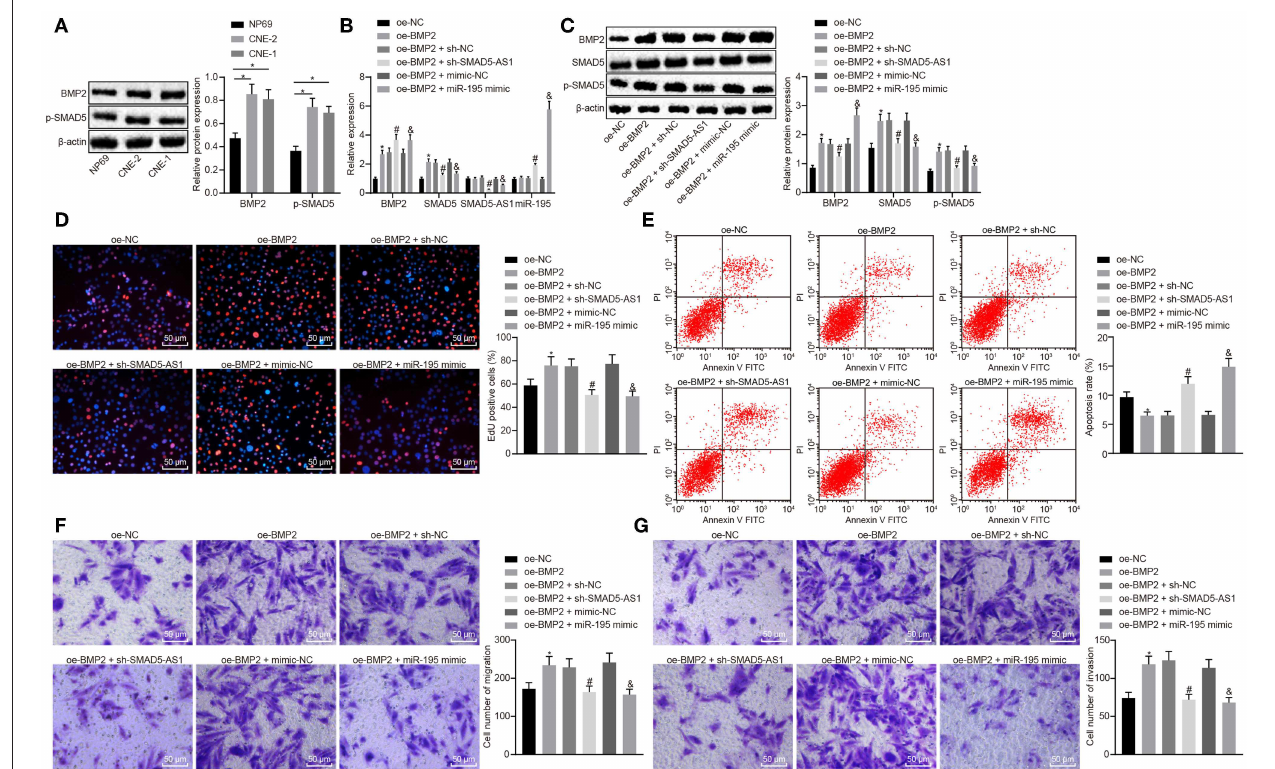
FIGURE 6 | Silencing of SMAD5-AS1 or miR-195 overexpression impeded CNE-2 cell proliferating, migrating and invading abilities via blocking the BMP2/SMAD5 pathway. (A) The protein expression of BMP2 and phosphorylated SMAD5 in CNE-2 cells measured using western blot analysis. *** p < 0.001 vs. NP69; ** p < 0.01 vs. NP69. (B) The expression of BMP2, miR-195, SMAD5, and SMAD5-AS1 in CNE-2 cells determined using RT-qPCR. (C) The protein expression of BMP2, SMAD5 and phosphorylated SMAD5 in CNE-2 cells measured using western blot analysis. (D) CNE-2 cell proliferation assessed by EdU assay. (E) CNE-2 cell apoptosis rate measured by flow cytometry. (F) CNE-2 cell migration evaluated by Transwell assay (200 × , scale bar = 50 um). (G) CNE-2 cell invasion evaluated by Transwell assay (200 × , scale bar = 50 um). In (B–G) , * vs. the oe-NC group, # p < 0.05 vs. the oe-BMP2 + sh-NC group, & p < 0.05 vs. the oe-BMP2 + mimic-NC group. The measurement data were expressed as mean ± standard deviation. n = 6. Independent sample t -test was adopted to compare data between two groups. The experiment was repeated 3 times.